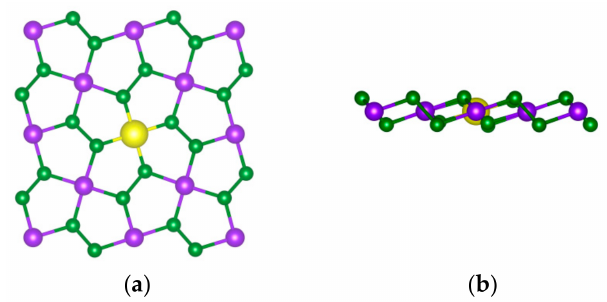
Figure 1. Top ( a ) and side ( b ) views of PdSe 2 configuration. Green, purple and yellow balls represent Se, Pd, and dopant (Cr, Mn, Fe, Co and Ni atoms)